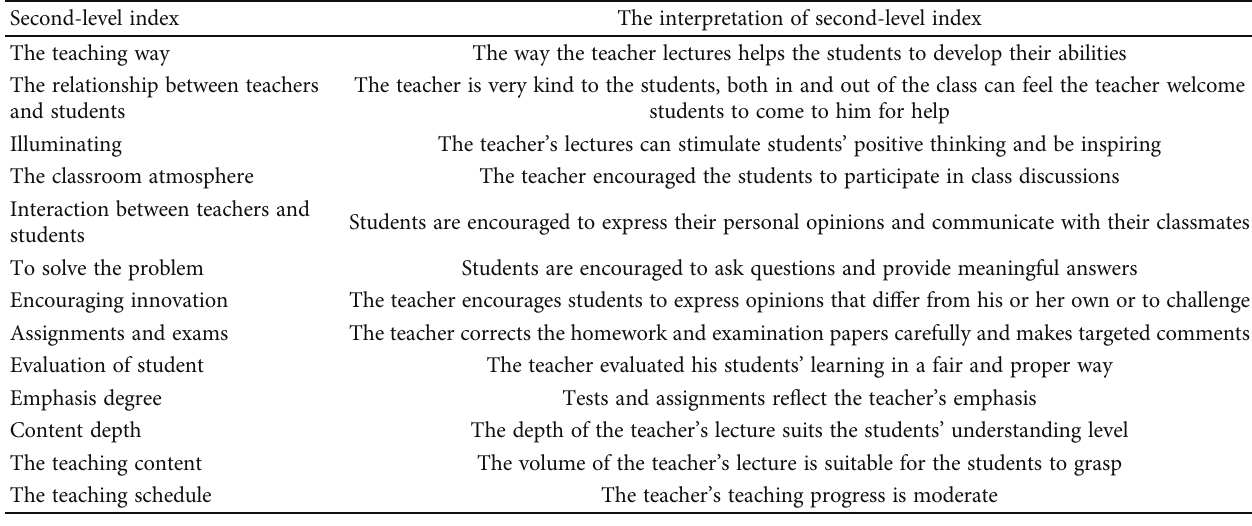
Table 12: Comprehensive evaluation index system of teaching reform projects ( fi rst-level index: teachers ’ teaching methods).